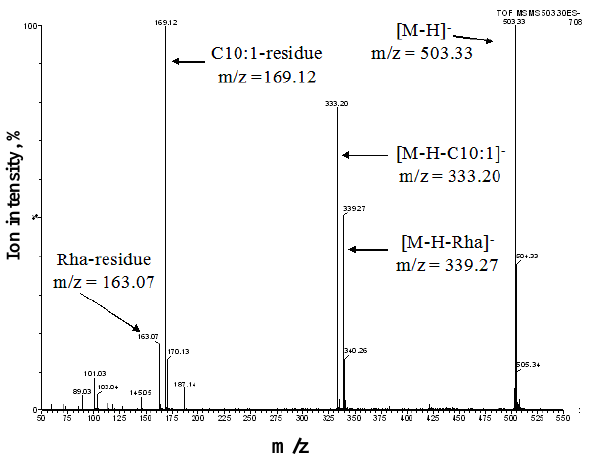
Fig. 3. Effect on the surface tension of water of different standard compounds as function of their molar concentration (curves with filled triangles): sodium chloride: red; ammonium sulfate: green; malonic acid: dark blue; HULIS: grey; monogalactosyl diacylglyc- eride: pale blue; digalactosyl diacylglyceride: orange; surfactin: black; rhamnolipid (extract 1): dark purple; rhamnolipid (extract 2): pale purple. Comparison with the surface tension of aerosol sample extracts (curves with open circles): coastal site (Aspvreten, Swe- den): brown; marine site during algae bloom (Sweden): clear blue; temperate forest (Hyyti¨al¨a, Finland): pale green; Amazonian forest (Manaus, Brazil): dark